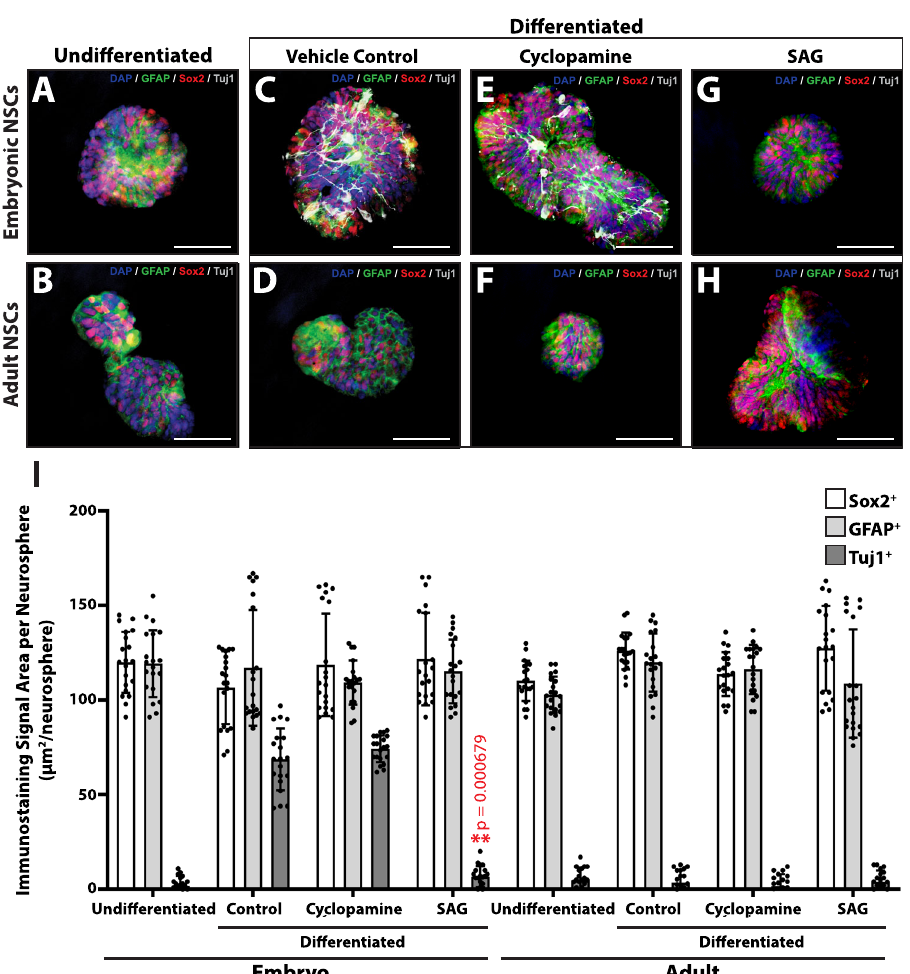
Fig. 4 Comparisons of differentiation capacities of embryonic vs adult lizard tail NSCs and sensitivities to Hedgehog signaling in vitro. A , B Representative undifferentiated neurospheres derived from A embryonic lizard tail NTs and B adult tail spinal cords analyzed by Sox2, GFAP, and Tuj1 IF. C – H Representative embryonic and adult neurosphere cultured under differentiation conditions for 14 days treated with C , D vehicle control, E , F cyclopamine, or G , H SAG analyzed for Sox2, GFAP, and Tuj1 expression. Bar = 50 μ m. I Quanti fi cation of embryonic and adult NSC neurosphere differentiation in response to treatment with cyclopamine and SAG. NSCs derived from embryonic and adult lizard tails were cultured as neurospheres under differentiation conditions supplemented with vehicle control, cyclopamine, or SAG and analyzed by Sox2, GFAP, and Tuj1 IF. Sox2, GFAP, and Tuj1 signal areas are presented ( n = 20 for each condition). Data are presented as mean values + / − SD. Two-way ANOVA with pairwise Tukey ’ s multiple comparison tests was used. ** p < 0.001, compared to corresponding vehicle controls. Source data are provided as a Source data fi (Supplementary Fig. 13). Embryonic NSC neurogenesis was unaffected by cyclopamine treatment but was inhibited by SAG (Fig. 4E, F) (Supplementary Fig. 13). Adult NSCs did not express DCX, NeuroD2, or Tuj1 under any condition tested (Fig. 4D, F, H) (Supplementary Fig. 13). These results suggested that embryonic, but not adult, lizard NSCs were capable of neural differentiation under Hedgehog-free conditions. Findings per- taining to the differences between embryonic and adult NSC identity and differentiation are summarized in Fig. 5.